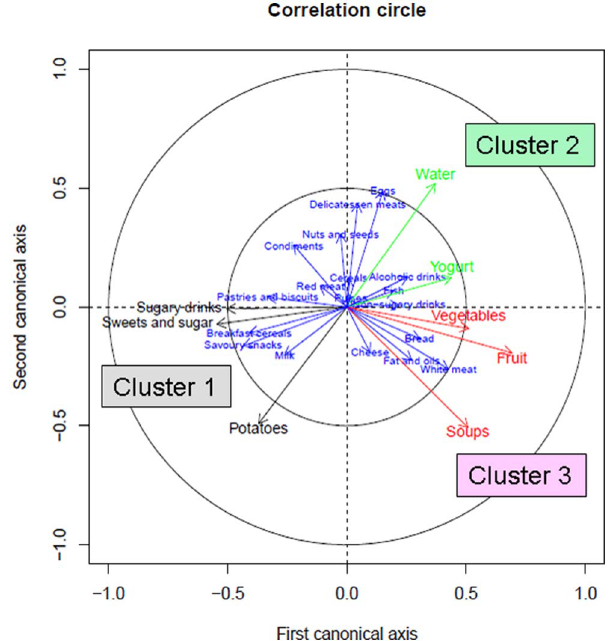
Figure 2. Canonical analysis: graphical representation of the food categories by cluster. A graphical representation of the food categories that created the distinction between the clusters i.e. those which were strongly correlated with canonical axis (Can) or significantly different between clusters (KW test with Bonferroni correction). The can 1 axis separates Cluster1 from 2 or 3, the can 2 axis separates Cluster 2 from 1 or 3. If the food category is strongly correlated with the two canonical axes it separates the three clusters at the same time. Food categories shown in black characterise Cluster 1, in green characterise Cluster 2, and in red characterise Cluster 3. The projection of each food or drink category on each canonical axis represents the contribution of this category to the building of this canonical axis. Therefore, if a category has a high contribution to the first axis (e.g. fruit), it discriminates Cluster 1 from Cluster 2 or Cluster 3. The food categories with weak contribution (below 0.5 in the inner circle) are shown in blue. These categories do not contribute to the discrimination/characteriza- tion of the three clusters. The distance between the centre point of the figure and the food category represents the correlation to the canonical axis and therefore the contribution to the separation of clusters. Food categories close to the axis between Clusters 2 and 3 indicate that intakes are similar, as for yogurt. Food category names have been shorted in this figure for readability.